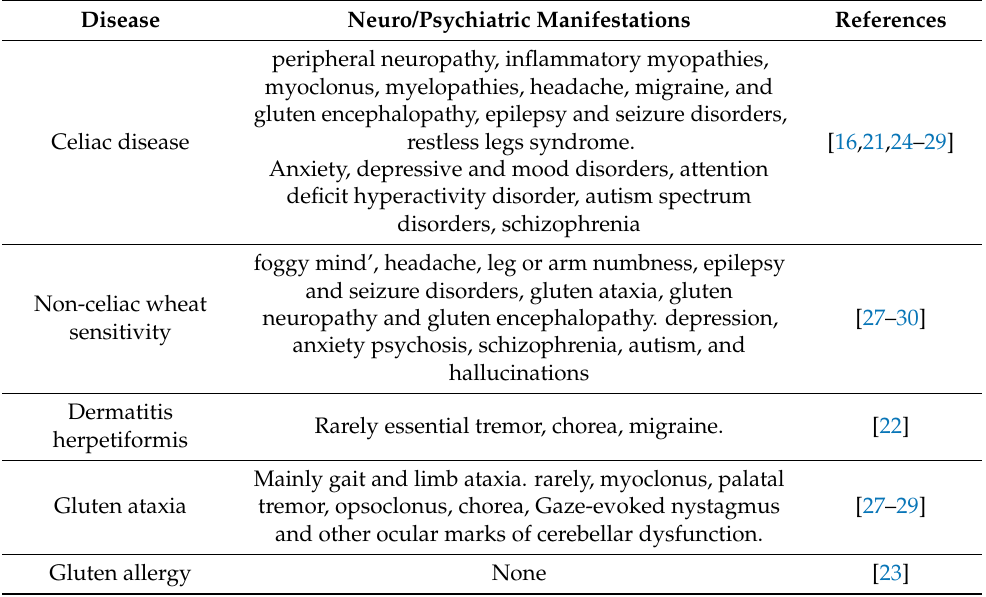
Table 1. Neuro and psychiatric manifestations in gluten related